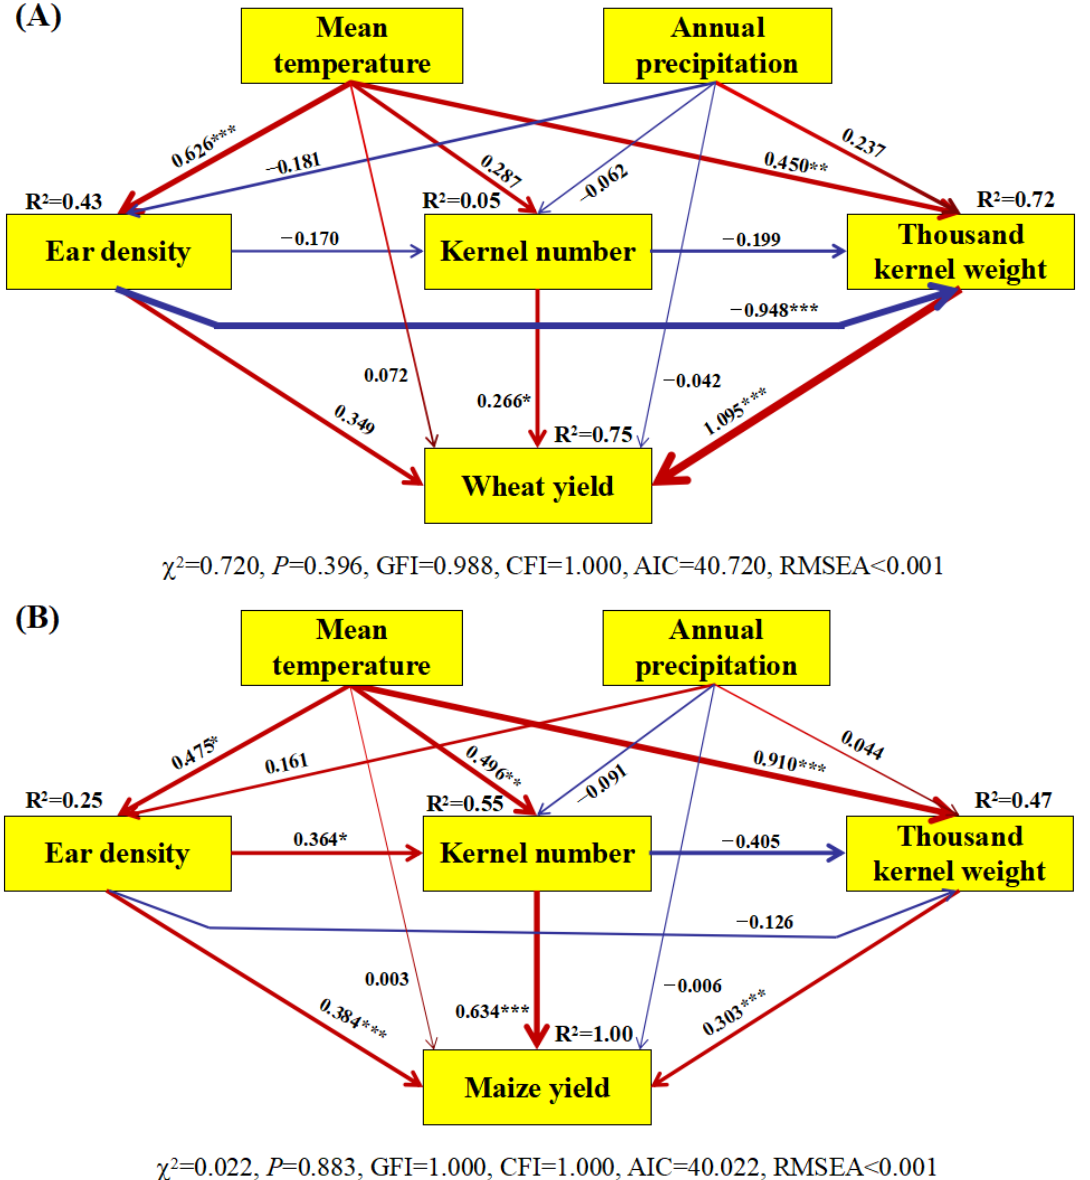
Figure 12. Direct and indirect effects of mean temperature, annual precipitation, and yield compo- nents on crop yield. Structural equation modeling was conducted for wheat yield ( A ) and maize yield ( B ). Single-headed arrows indicate the hypothesized direction of causation. Red and blue arrows indicate positive and negative relationships, respectively. The arrow width was proportional to the strength of the relationship. The numbers adjacent to the arrows are the standardized path coefficients. Significant differences are indicated: *, p <0.05; **, p <0.01; ***, p <0.001.